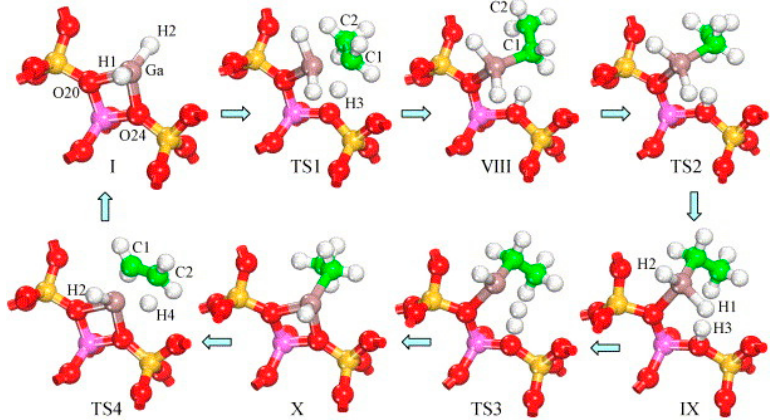
Figure 20. Molecular transformations during dehydrogenation of ethane on Z − [HGaH] + site (terminal SiH 3 are not shown for clarity). Reprinted with permission from ref [119]. Copyright 2005 Elsevier.